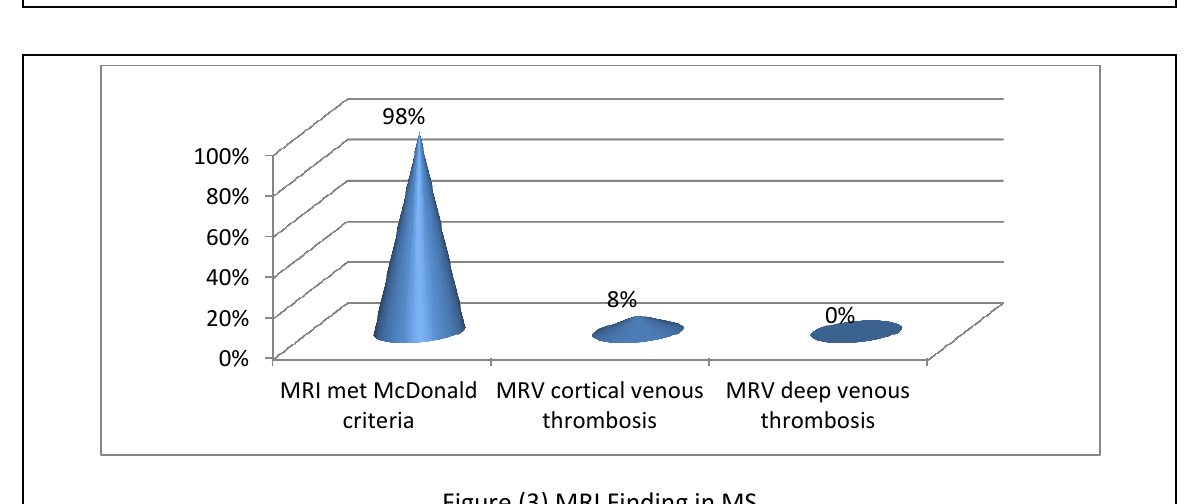
Figure (3) MRI Finding in MS